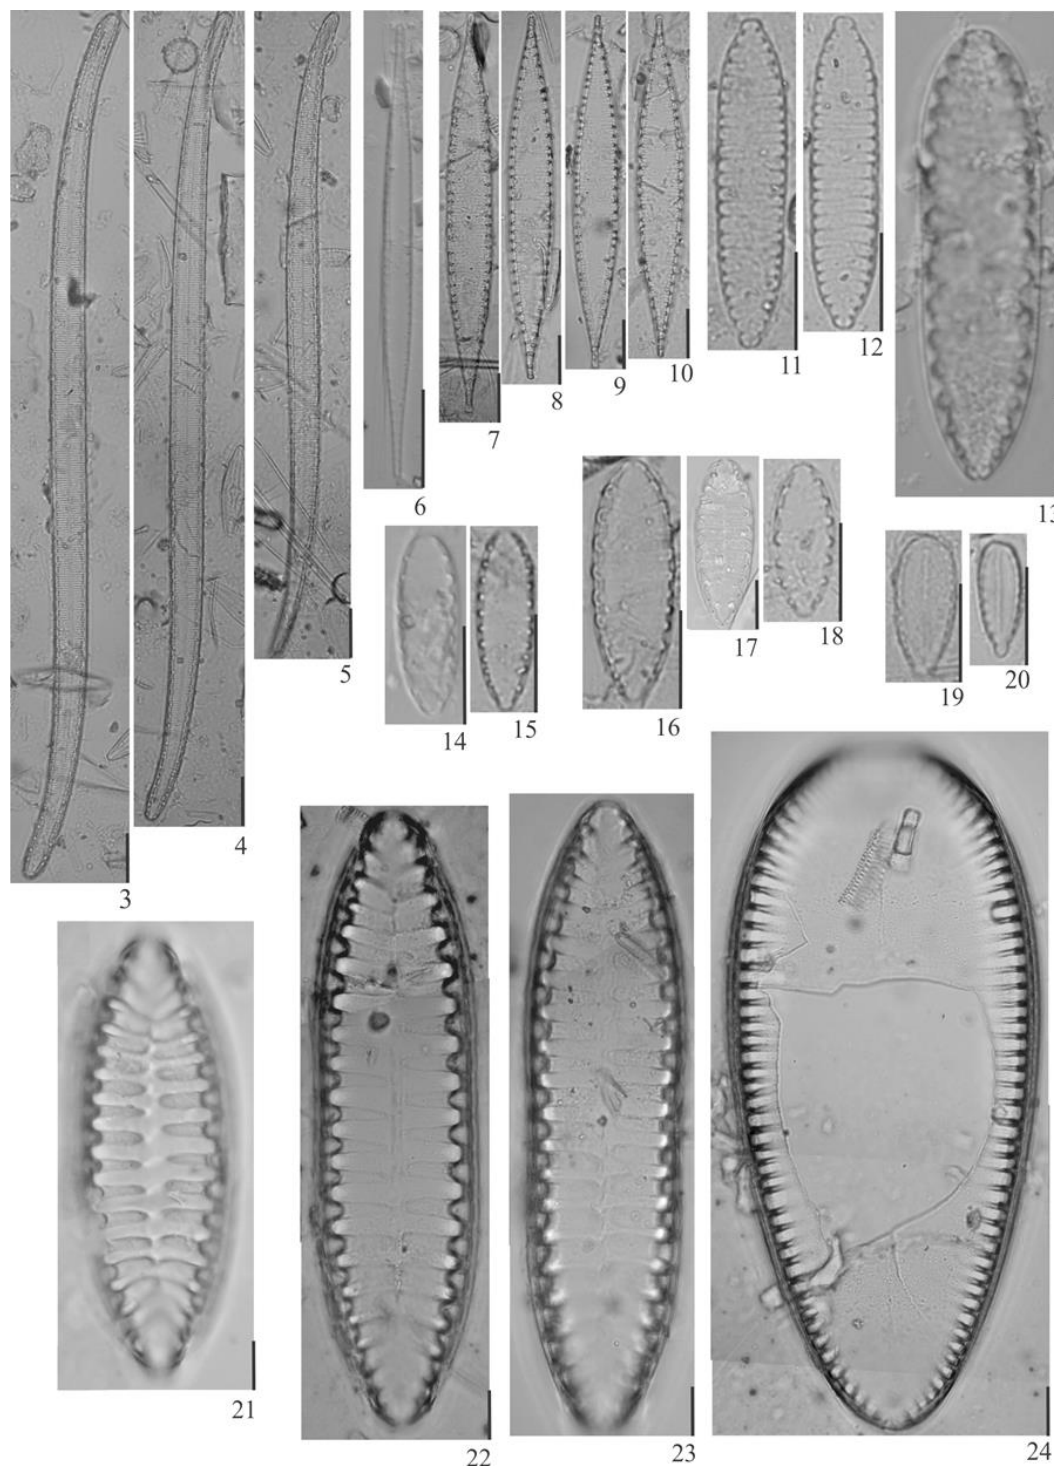
Figures 3-24. Surirellales from surface sediments, São Paulo state, Brazil. Scale bar: 10 µm. 3-5. Stenopterobia curvula . 6. Stenopterobia delicatissima . 7-10. Stenopterobia sp. 1. 11-12. Surirella angusta . 13. Surirella roba . 14-15. Surirella sp. 3. 16-18. Surirella sp. 2. 19-20. Surirella stalagma . 21. Surirella sp. 4. 22-23. Surirella linearis . 24. Surirella guatimalensis